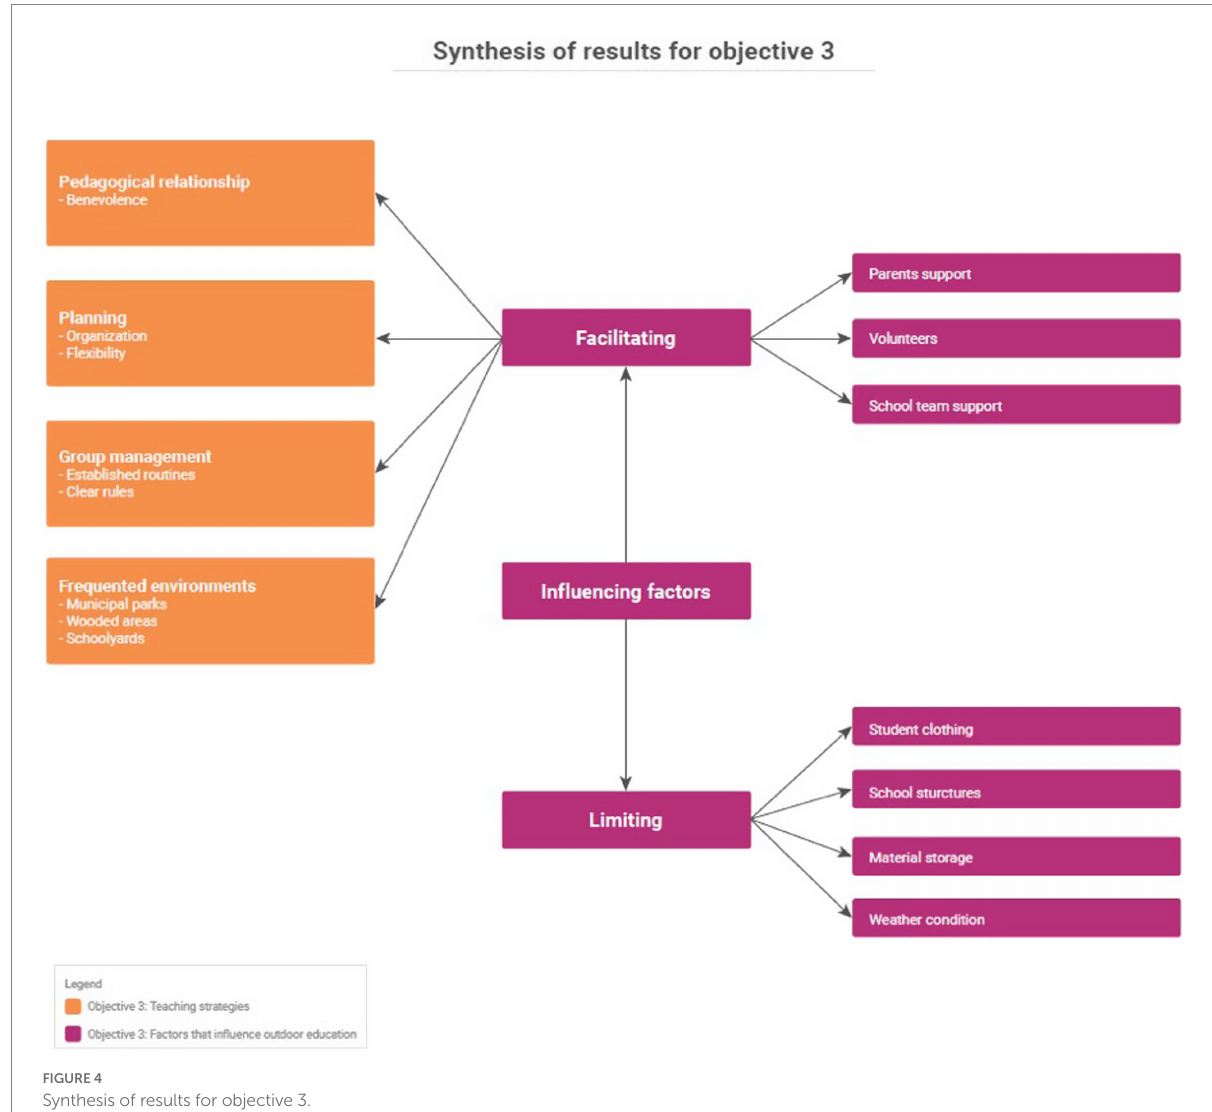
FIGURE 4 Synthesis of results for objective